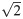
Approximate cα values as a function of α.The values are shown for 1000 α randomly selected from the interval (1, 2). The cα of algebraic (2, 3, σ, σ − 1/2) and non-algebraic (e) irrationals are also shown in red and black, respectively. We estimated cα, based on Eq 8, as cα ≈ inf{Lmax
δ ∣ δmin < δ < δmax}, for different noise ranges [δmin, δmax] in the three panels: (a) 0.05 < δ < 0.2, (b) 0.005 < δ < 0.05, (c) 0.001 < δ < 0.01. Approximate Lmax values are indicated on the top of the panels for α = σ.